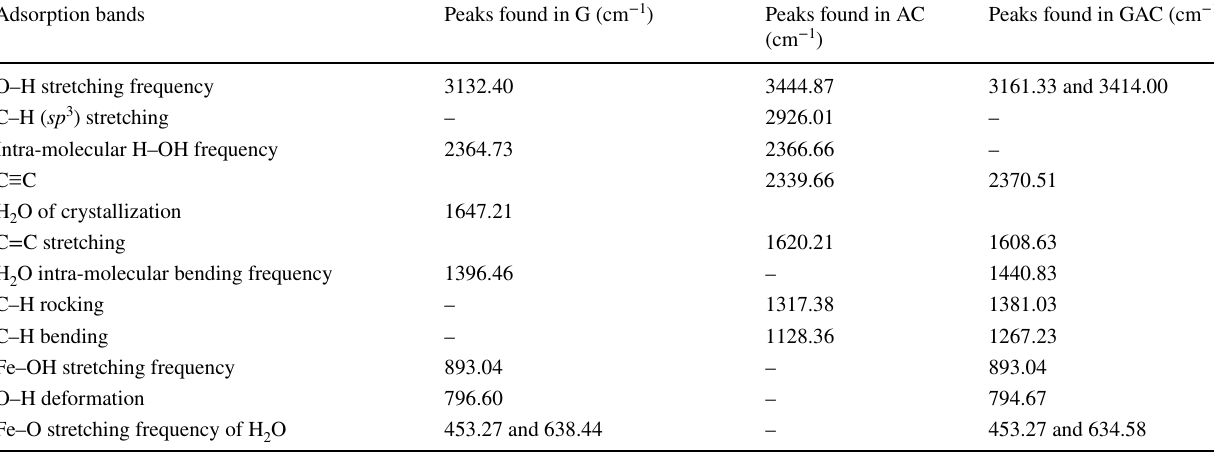
Table 1 Summary of important peaks observed in G, AC and GAC Adsorption